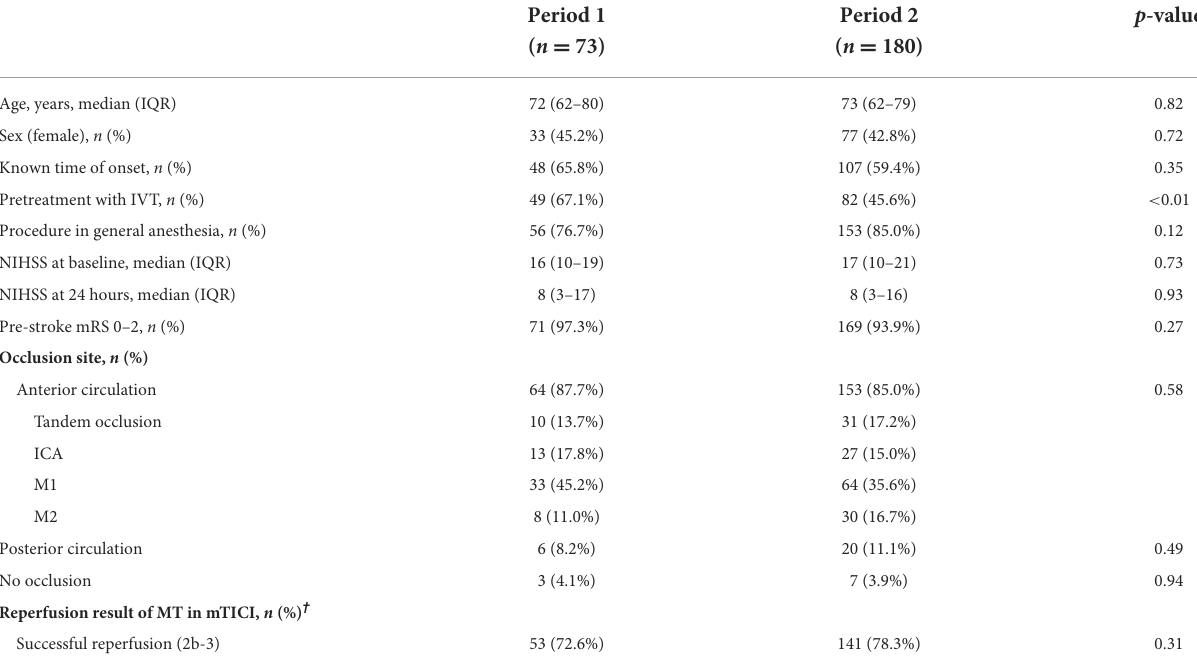
TABLE 1 Baseline